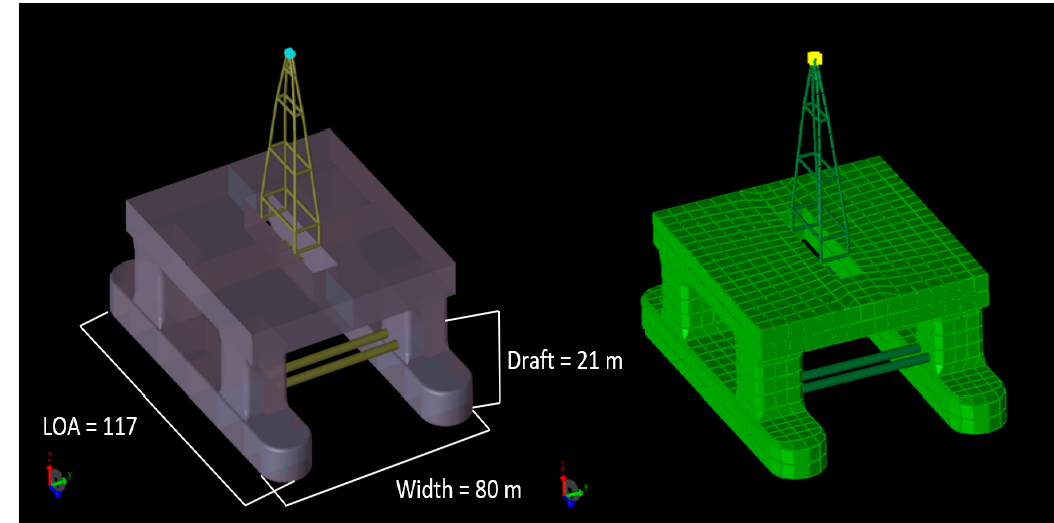
Figure 1. Hull of a semisubmersible model.